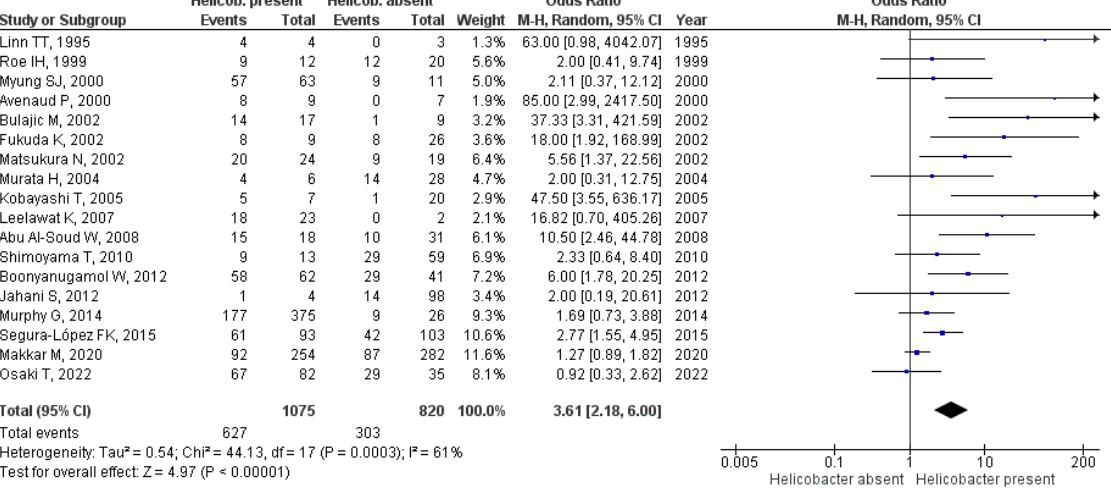
Figure 2. Forest plot of 18 studies evaluating the risk of hepatobiliary tract malignancies according to the presence or absence of Helicobacter spp. infection detected by direct microbiological methods using a random ‐ effects model.